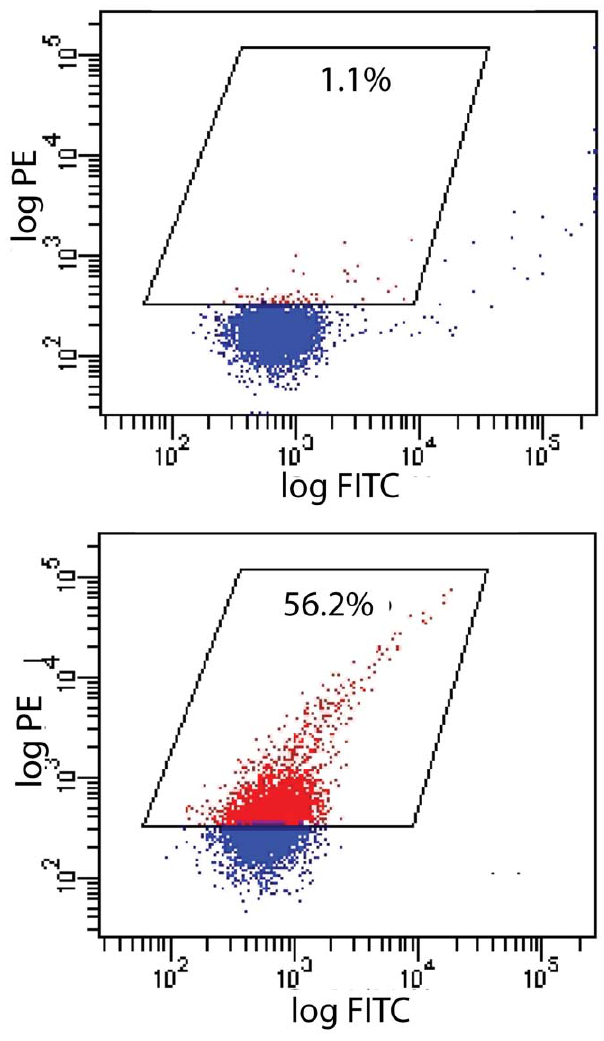
Figure 5. MACS/FACS results of MACS_545 Sample. Flow cytometry analysis of the fraction cell binding through conventional MACS plus FACS sorting after incubation with Streptavidin-Phycoery- thrin (SAPE) labeled biotinylated PA protein target. The intensity of PE fluorescence ( y -axis) represents either the expression of the surface peptide or affinity of the target to the display peptide. In the top dot plot, the cells are incubated with SAPE + biotin-PA prior to arabinose induction (negative control). The bottom dot plot shows the fraction PA bound after arabinose induction of the MACS_545 cells. doi:10.1371/journal.pone.0026925.g005 valves are located on the underside of the cartridge, which allow for the redirection of flow to one of the elution ports (Fig. 1a) during washing of unbound cells (to negative cell outlet) or elution of magnetically bound cells (positive cell outlet) (Fig. 2). These valve membranes require a force of , 15 lb/in 2 to seal and are robust enough to be actuated multiple times.